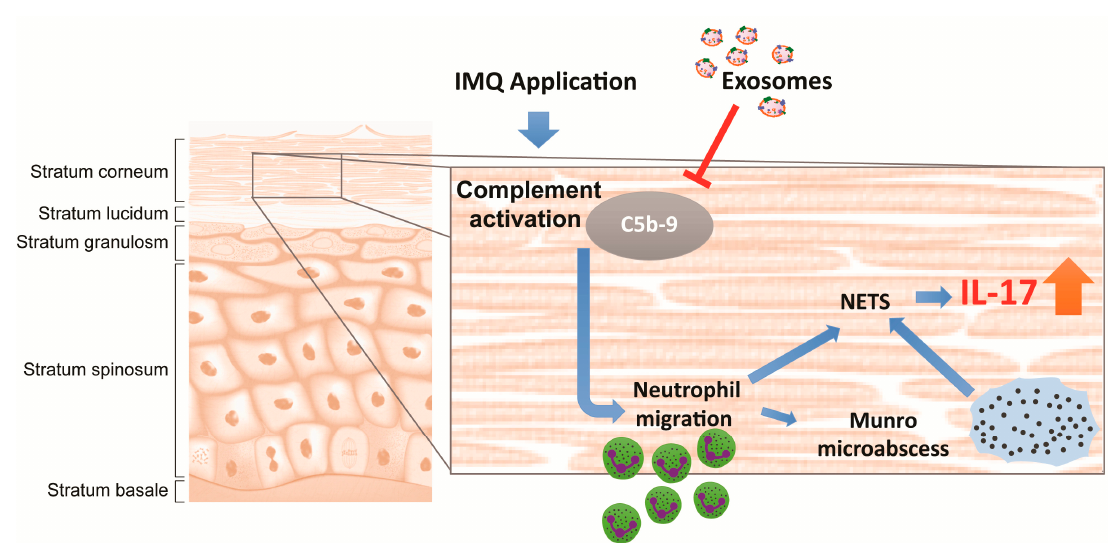
Figure 6. Illustration showing topically applied MSC exosomes localize to the stratum corneum, where they inhibit complement activation caused by the IMQ application, leading to attenuation of NETosis and subsequent release of IL-17 through neutrophil extracellular traps (NET). The T arrow indicated the inhibition of C5b-9 complex assembly by exosomes.